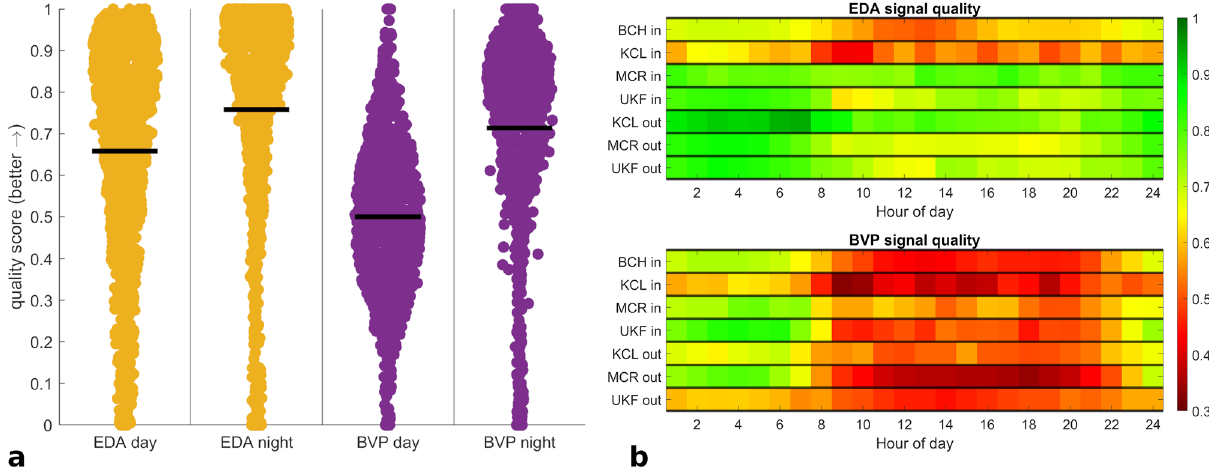
Figure 6. Comparison of EDA and BVP signal quality scores when grouping data by day- and